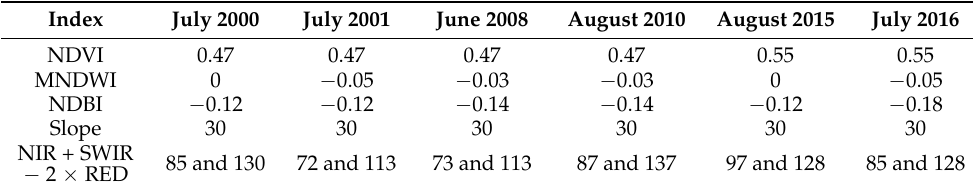
Figure 3. Decision tree classification process (August 2010 as an example). Table 2. Thresholds of indices for decision tree Table 1. Indices for decision tree classification.